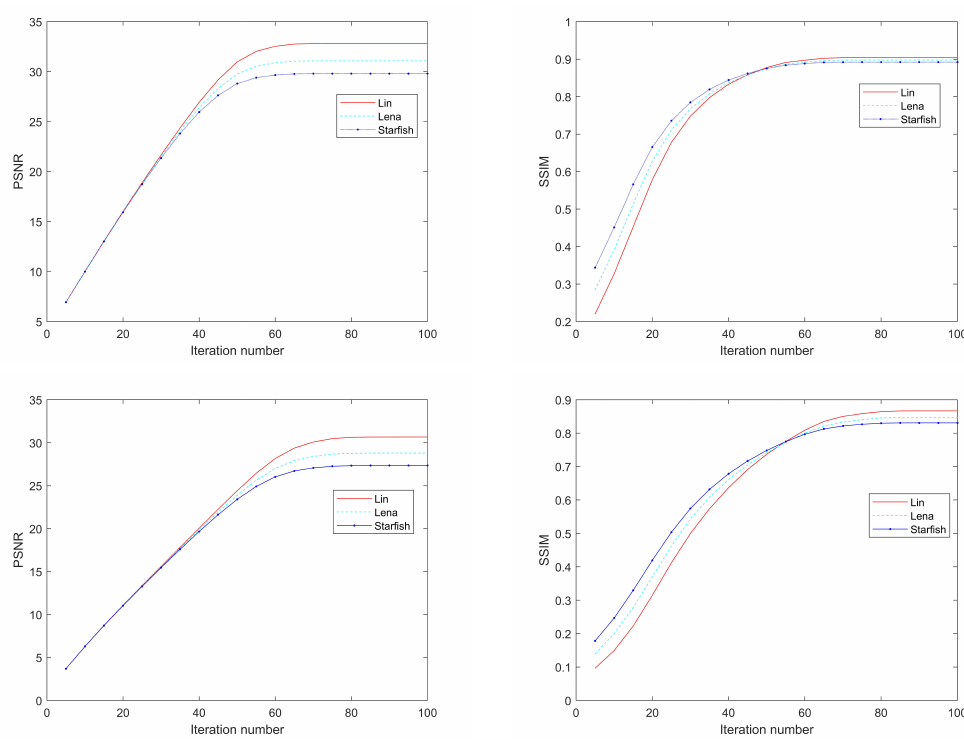
Figure 6. Top row : Curves of PSNR and SSIM versus iterations number at η = 0.02. Bottom row : Curves of PSNR and SSIM versus iterations number at η = Figure 6. Top row: Curves of PSNR and SSIM versus iterations number at η = 0.02 Bottom row: Curves of PSNR and SSIM versus iterations number at η = 0.04